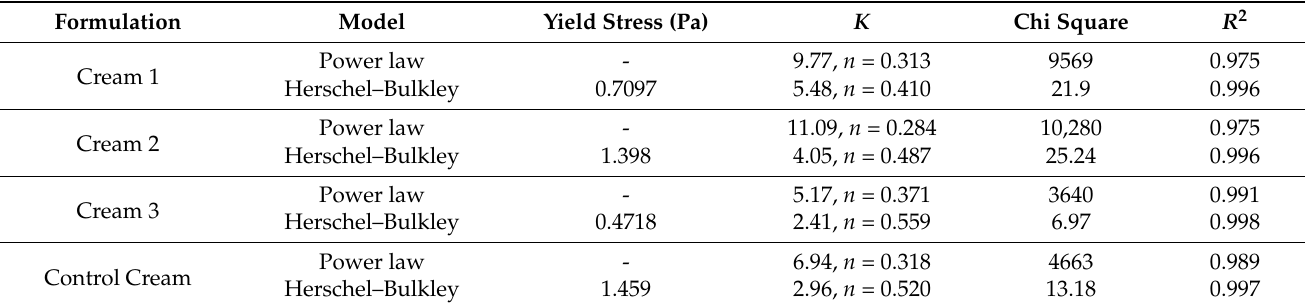
Table 8. Fitting of mathematical models to rheological data. The Power Law and Herschel–Bulkley models were fitted to Table 2.